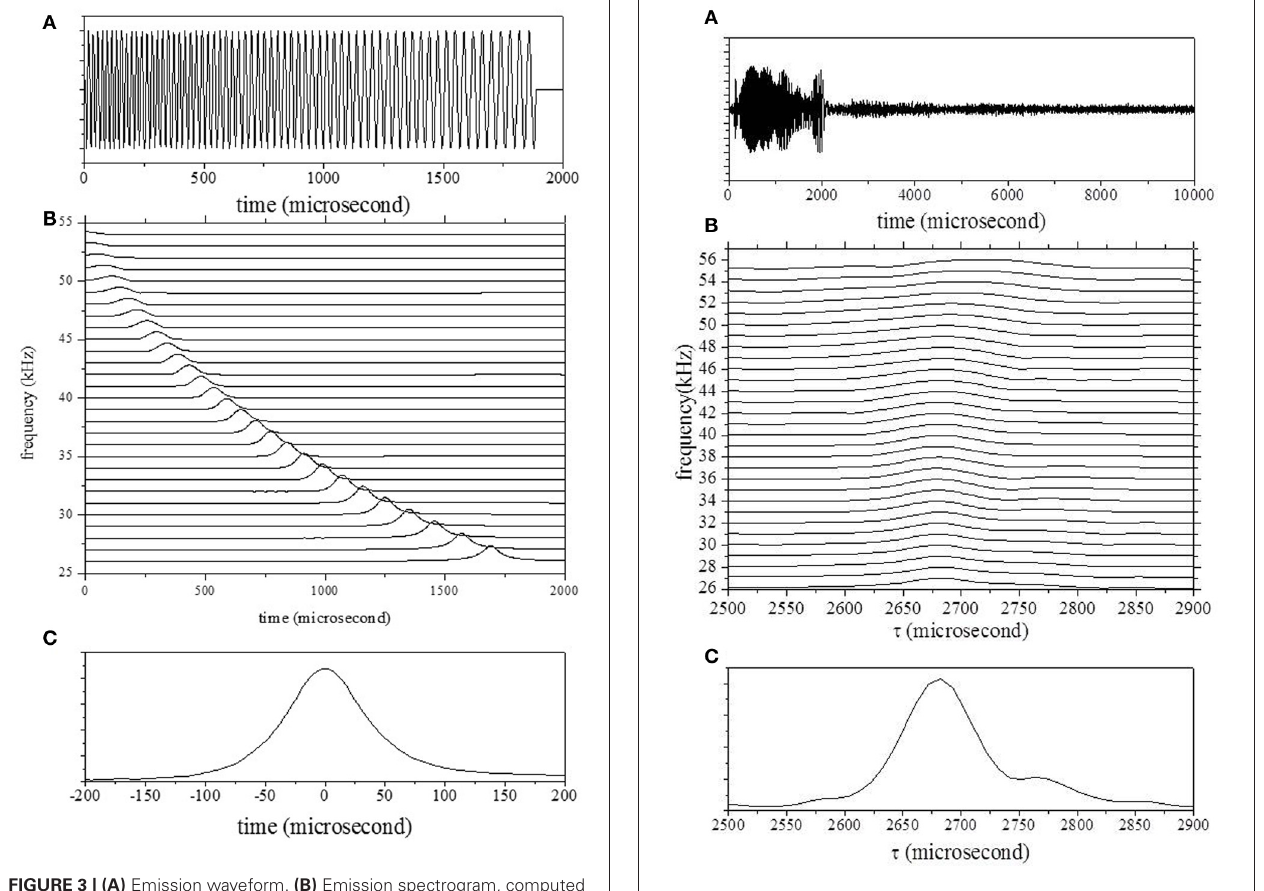
FIGURE 4 | (A) Echo waveform. (B) Range–frequency pattern computed from the spectrogram, through convolution of the Gaussian chirplets. (C) Averaged pattern computed by integration of bandpass filter channels.